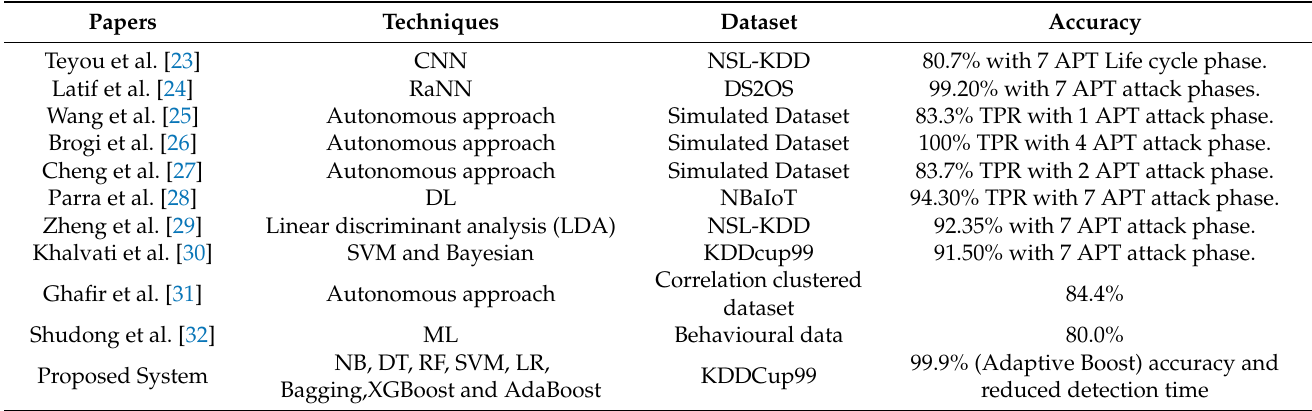
Table 13. Comparison of proposed methodology with existing